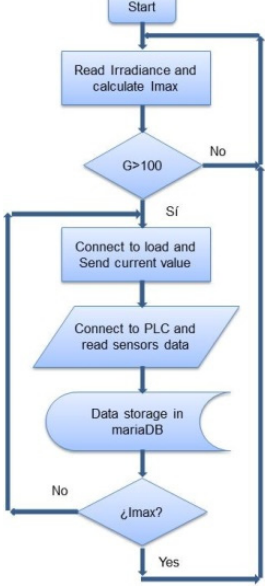
Figure 4. Flowchart of operations performed by the curve tracer.